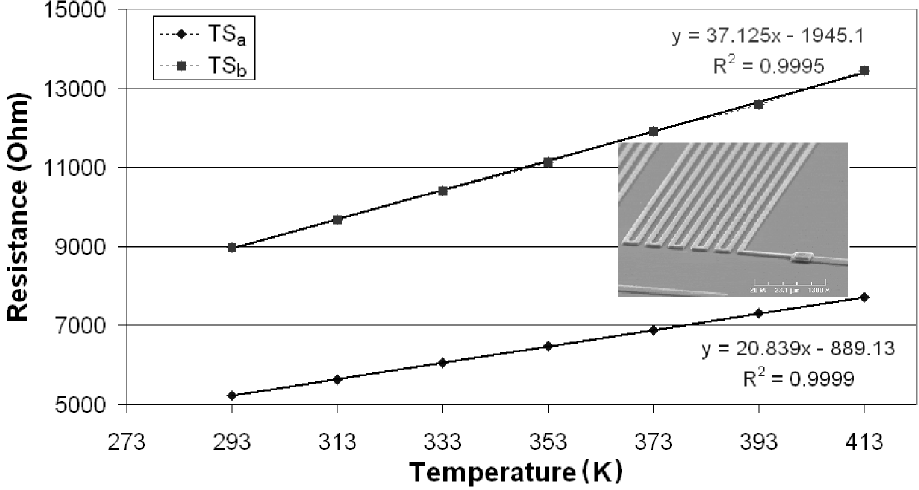
Figure 9. Temperature sensors performance.